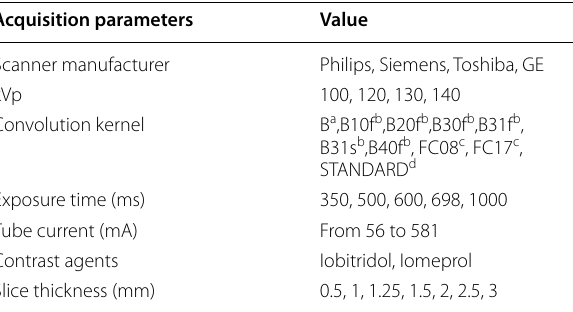
a Philips; b Siemens; c Toshiba; d G.E; e Non-ionic CA, market under the trade name Xenetix (Guerbert); f monomeric and water-soluble non-ionic, injectable iodinated contrast medium solution (Bracco)